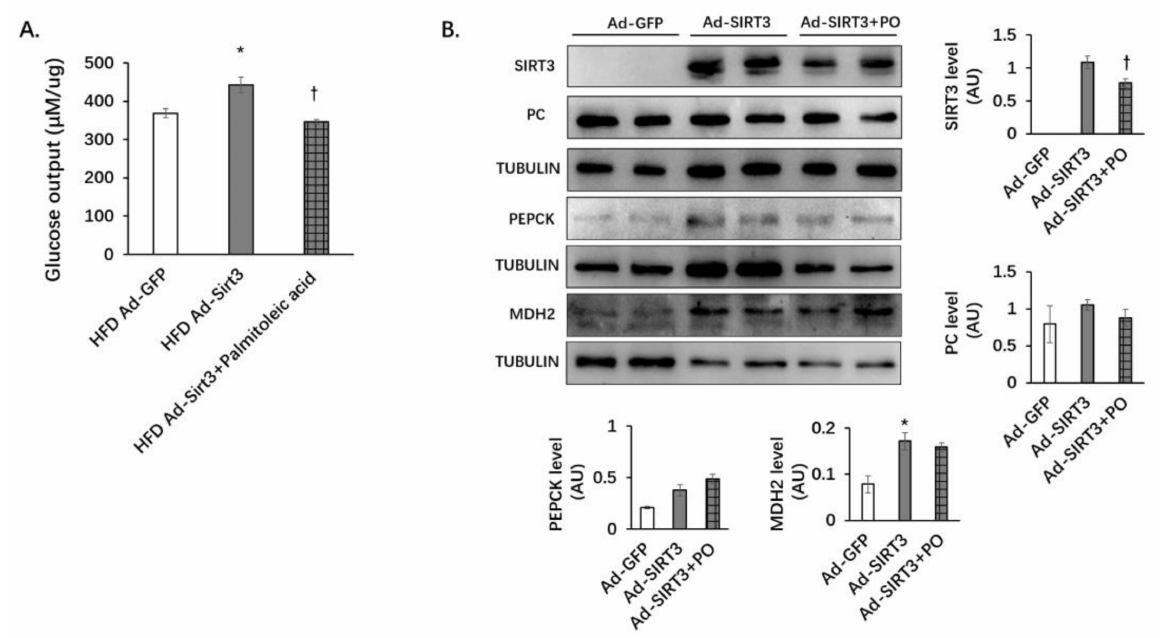
Figure 9. Palmitoleic acid reverses the increase in gluconeogenesis caused by SIRT3 overexpression in primary hepatocytes. Primary hepatocytes from mice fed with HFD were isolated and infected with Ad-GFP or Ad-SIRT3 adenovirus. Ad-SIRT3-infected hepatocytes were also treated with palmitoleic acid for 48 h. ( A ) Glucose production from primary hepatocytes. In the presence of substrates (20 mM lactic acid and 2 mM pyruvate), the primary hepatocytes were stimulated with 100 nM glucagon for 3 h to detect the content of glucose in the medium. ( B ) SIRT3, PC, and MDH2 protein levels were detected using Western blot analysis. The data are mean ± s.e. (error bars). n = 6 from